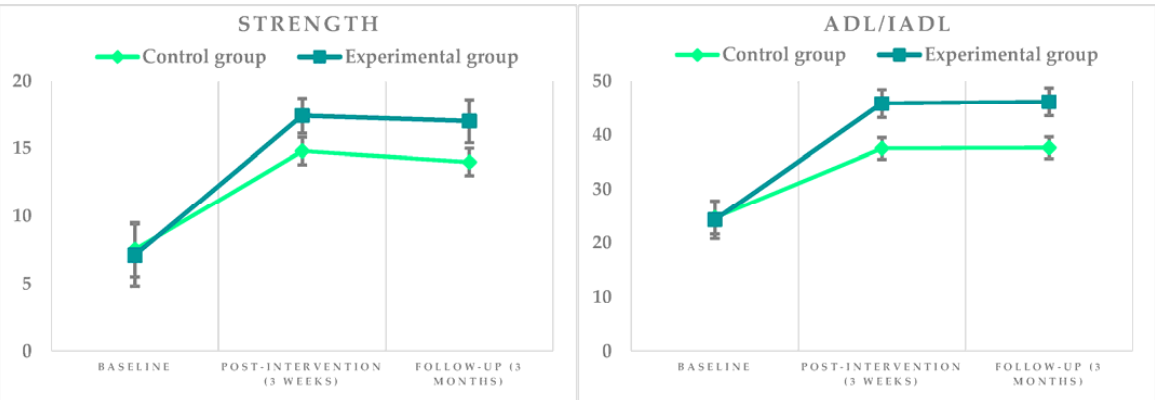
Figure 3. Graphic representation of the intervention’s effect on the total scores of strength domain (minimum: 4; maximum: 20) and ADLs/IADLs (minimum: 10; maximum: 50) of the SIS 3.0 instrument.